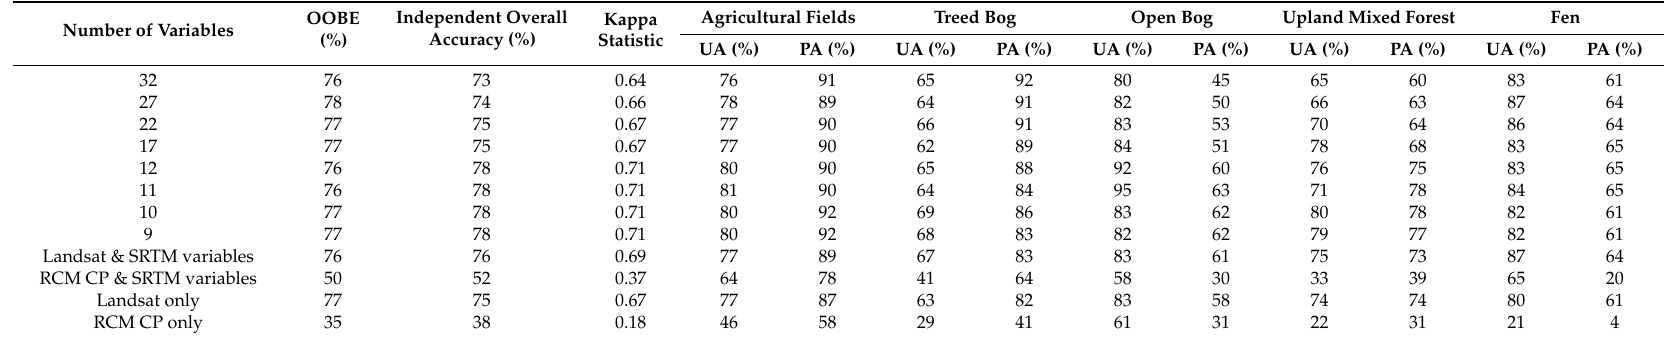
Table A9. Statistical results from the RCM CP NESZ − 19 dB (13 July 2014), Landsat-8 (27 June 2014), SRTM variables summer model. The first iteration was run with all 32 variables, and variables ranked to be unimportant were then removed until 9 variables remained. The final variables in the model with the highest independent overall accuracy (10 variables) in order of decreasing importance were the seven Landsat-8 bands, RV Intensity, Shannon Entropy Intensity, and SRTM